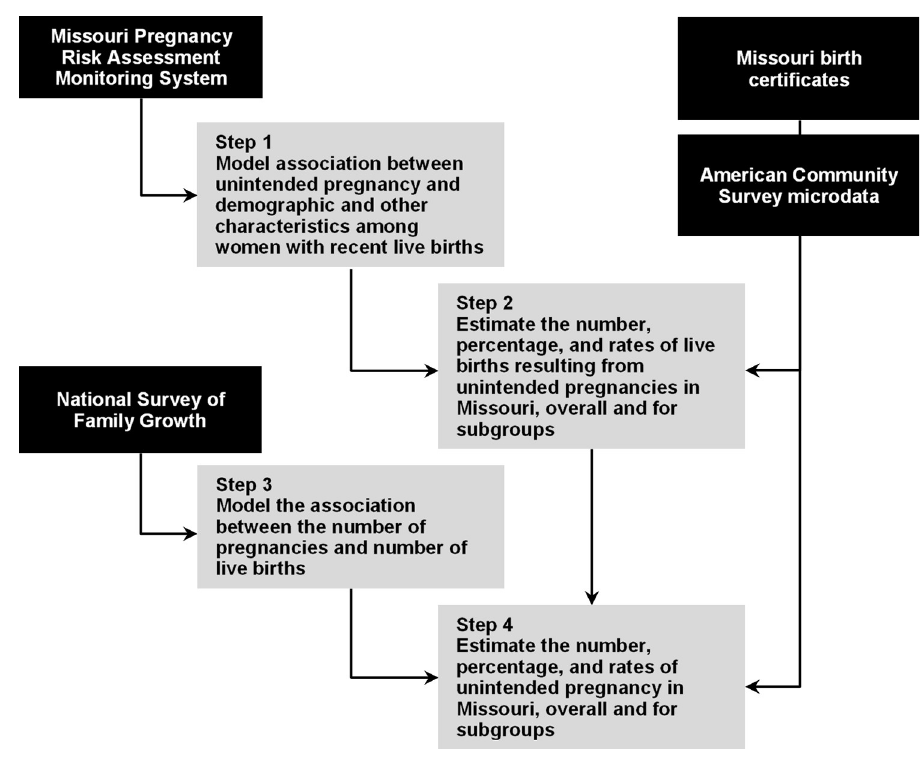
Fig 1. Data sources and analysis